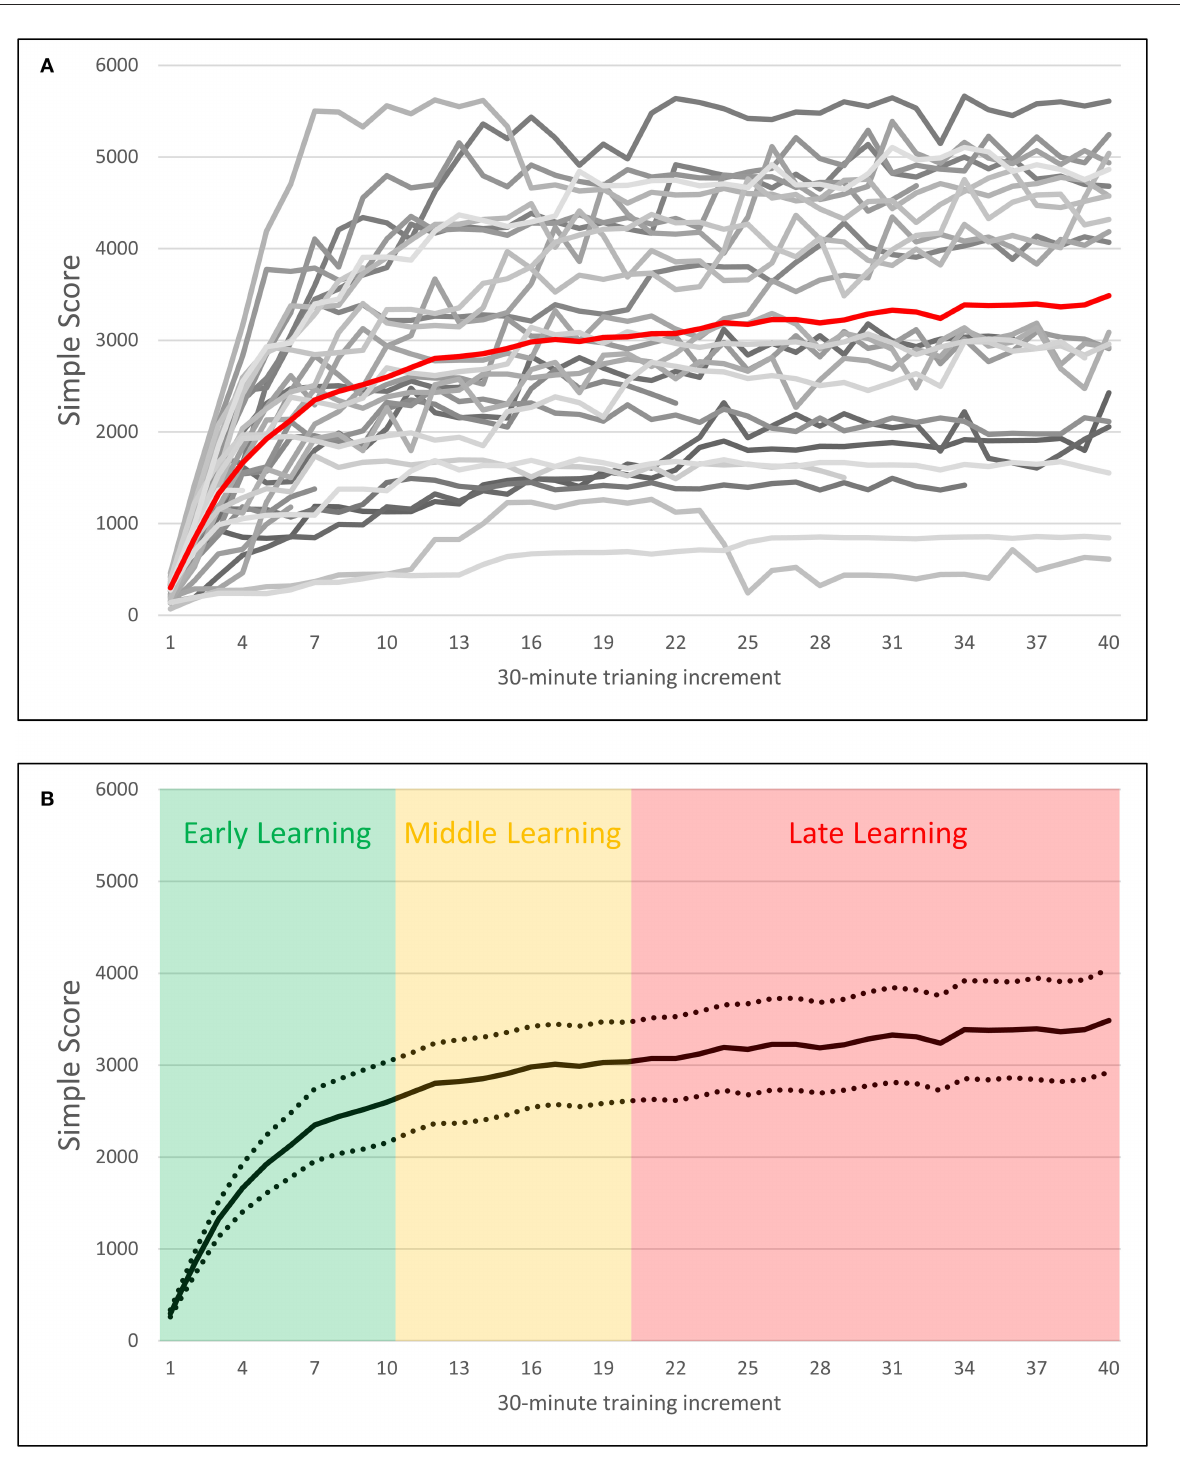
FIGURE4 Plots of block-wise Simple Score by 30-min training increment over 20h of training. (A) Depicts scores over time for individual participants represented in grayscale, with the average score over time plotted in red. (B) Depicts average scores over time with 95% confidence intervals, as well as demarcations of early, middle, and late training